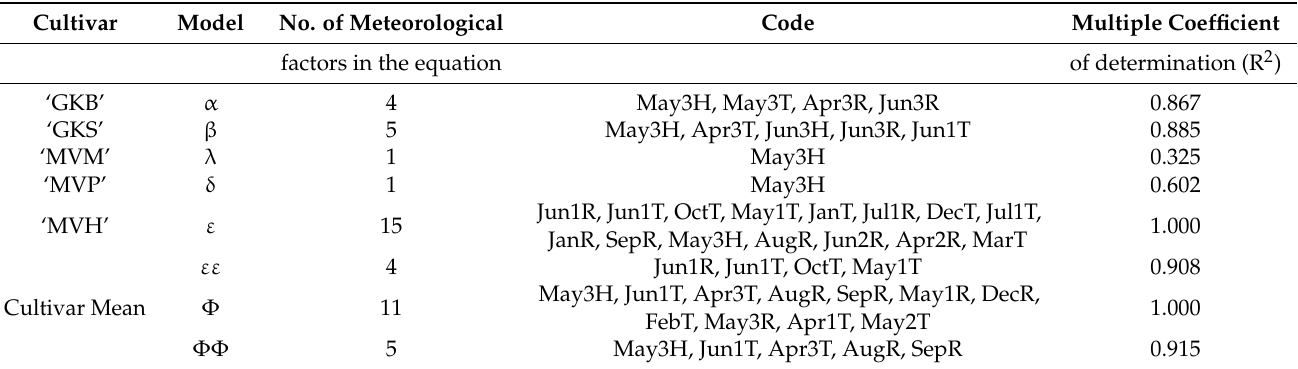
Table 5. Characteristics of the Minolta b* functions developed by stepwise